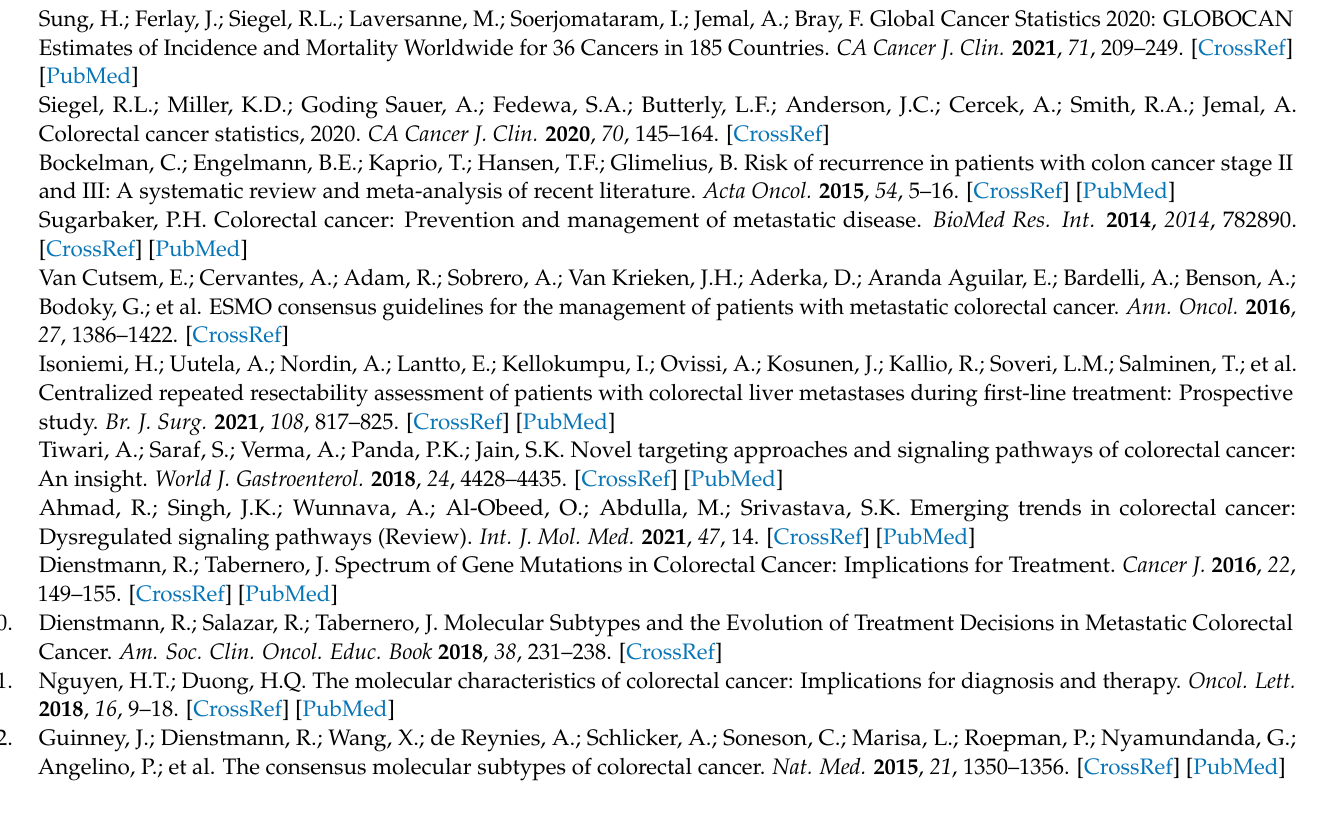
Table S1: The association between mutated genes and overall survival of patients with metastatic colorectal